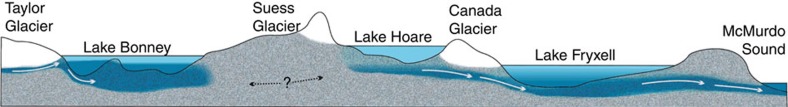
Conceptual diagram depicting predicted hydrological connectivity.Two distinct regions of subsurface brine were identified in the MDV. The ‘?' indicates the zone between Lake Bonney and Lake Hoare where no connectivity was identified with our survey.